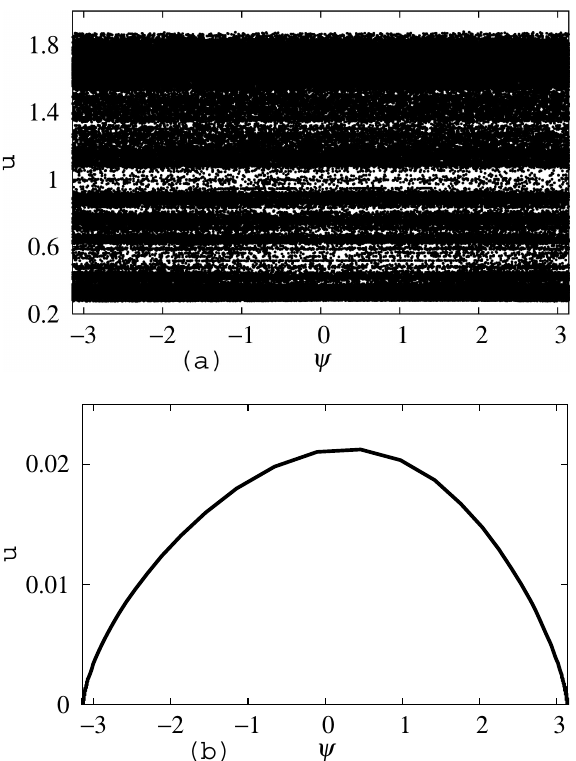
Fig. 4. Phase space for the map G n at Q = 2 × 10 − 3 . (a) A sin- gle trajectory of length 2 × 10 5 . The initial point (10 − 4 , 3 × 10 − 1 ). (b) A single trajectory of length 8 × 10 3 . The initial point (10 − 4 , 10 − 5 ).